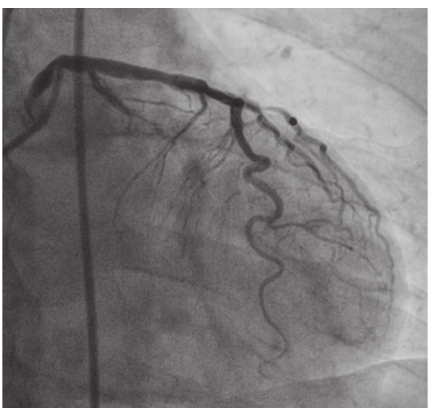
Figure 3: Coronary angiogram of the left coronary artery, showing almost totally occlusion of the circumflex artery.